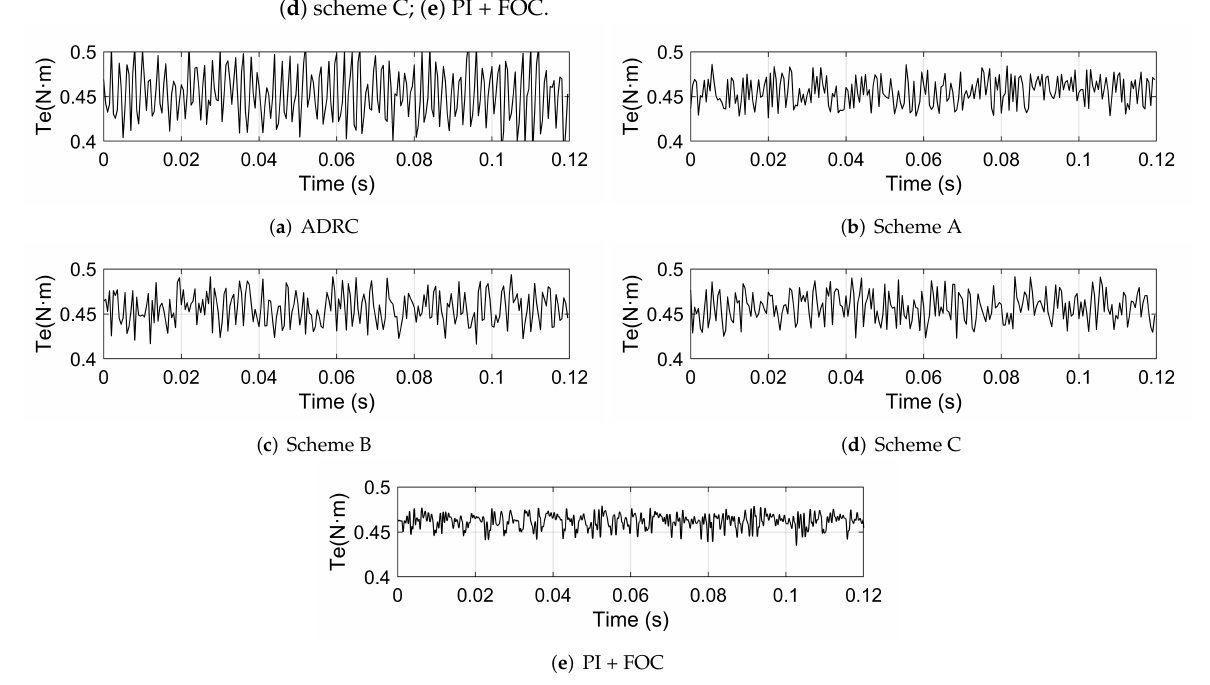
Figure 12. The motor torque of the system based on: ( a ) ADRC; ( b ) scheme A; ( c ) scheme B; ( d ) scheme C; ( e ) PI +